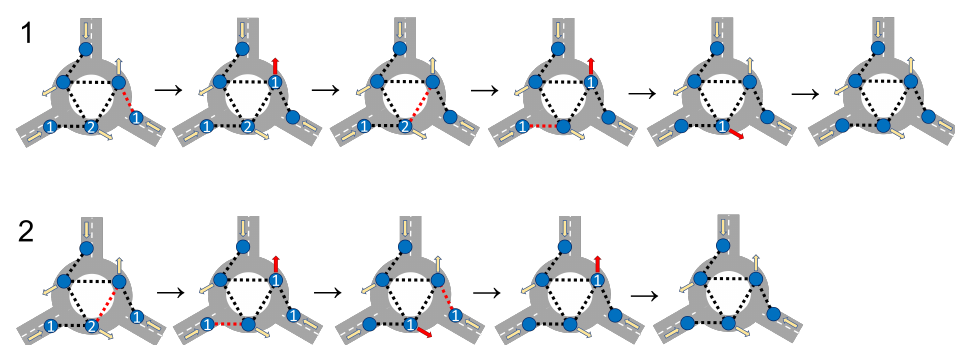
Figure 12: Minimum number of turns, for a sample configuration, to allow all the vehicles to exit from the system for a given priority rule. On the first line, we assume right-hand priority, which requires 6 different turns. On the second line, we assume perfect roundabout priority and, in this case, five different turns are sufficient. Num- ber 2 represent a vehicle that wants to exit at the second possible gate, number 1 a vehicle intentioned to exit at the first available gate. At each step we draw in red color the operator which is